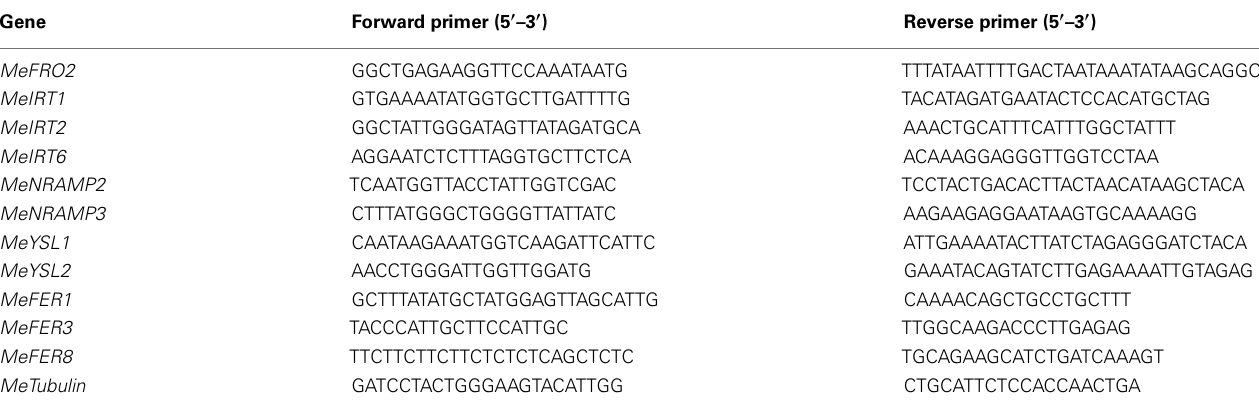
Table 1 | Forward and reverse primers for semi-quantitative PCR amplification.